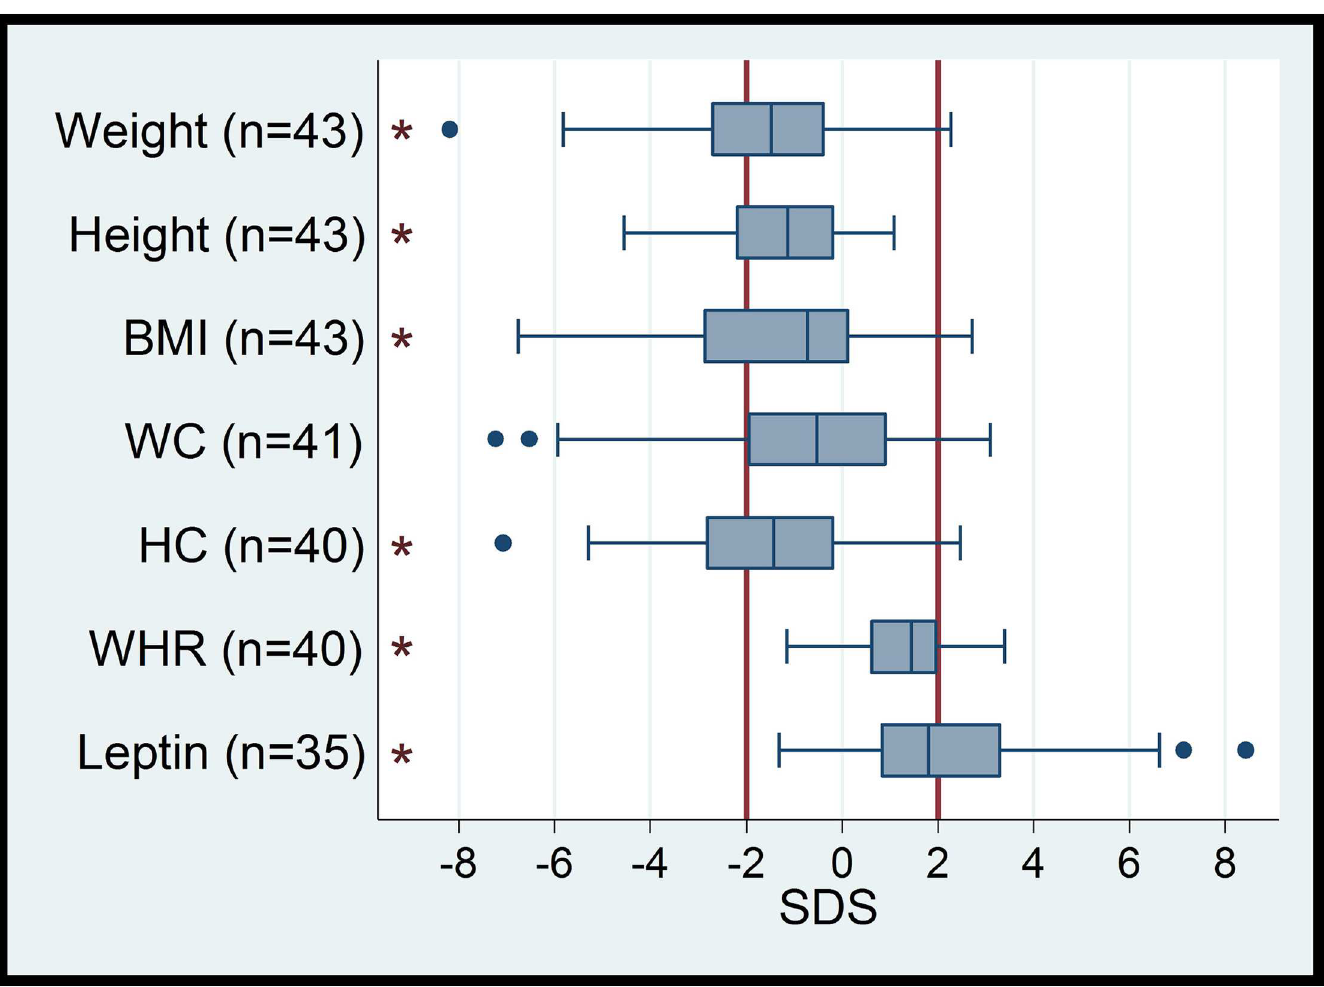
Fig 2. Distribution of auxological data in SMA patients (BMI = body mass index, WC = waist circumference, HC = hip circumference, WHR waist- to-hip ratio, SDS = standard deviation score). Vertical lines in bold (- 2 SD, + 2 SD) indicate the reference range. Boxes indicate the interquartile range (IQR), whiskersindicate 1.5xIQR, black dots are outliers. Asterisks indicatea significantdeviationof the median from zero (p < 0.01) with a shift towards highervalues for WHR and leptin, as well as a shift to lower values for weight, height, BMI und